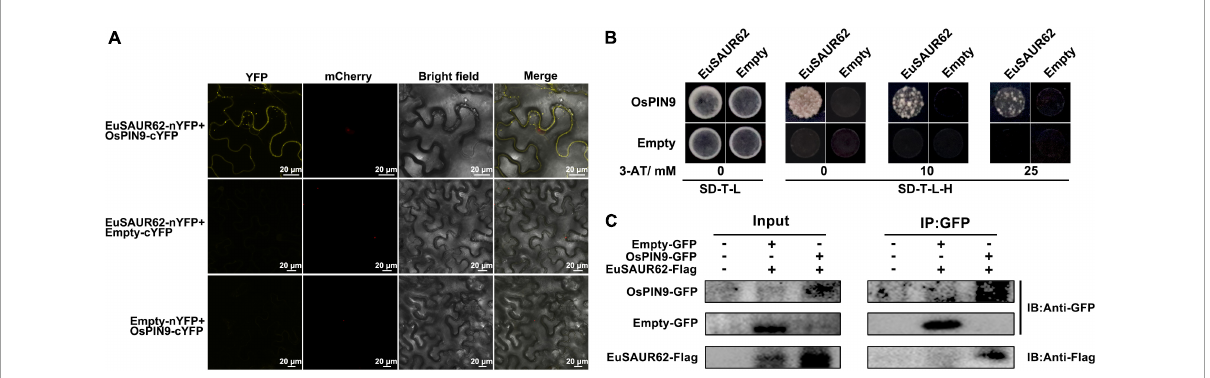
FIGURE6 Interaction of EuSAUR62 and OsPIN9. (A) EuSAUR62 and OsPIN9 were fused with the corresponding YFP parts for BiFC assay in tobacco leaves. Images including bright field, H2B-mCherry and YFP fluorescence were observed using a laser confocal microscope (Scale bar = 20 µ m). (B) Membrane yeast two-hybrid assay of the interaction of EuSAUR62 and OsPIN9. Interactions were determined based on cell growth on SD-T-L-H with 3-AT. IAA, Indole-3-acetic acid; OE-EuSAUR62 , EuSAUR62 overexpression lines; WT, wild type rice. (C) Tobacco leaves were transfected with constructs containing a p35S:OsPIN9-GFP and/or p35S:EuSAUR62-Flag . Proteins were immunoprecipitated with anti-GFP antibodies and subjected to western blot analysis with anti-Flag antibodies to confirm the presence of the OsPIN9 protein and to anti-GFP gel-blot analysis to reveal the EuSAUR62